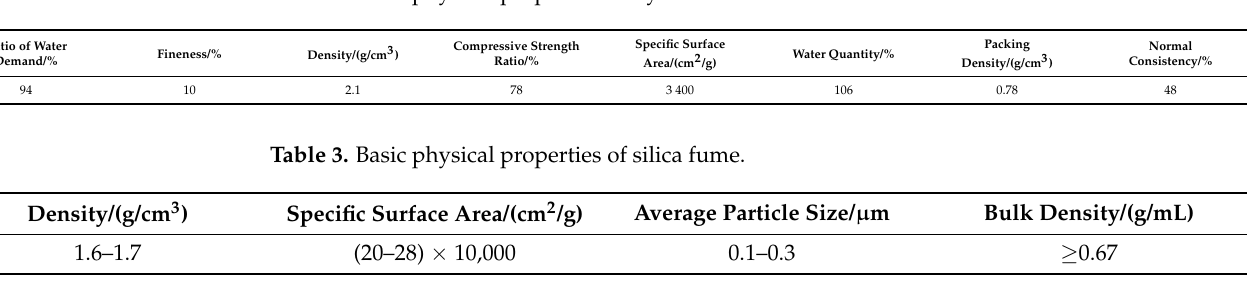
Table 4. Basic chemical composition of cement, fly ash and silica fume.